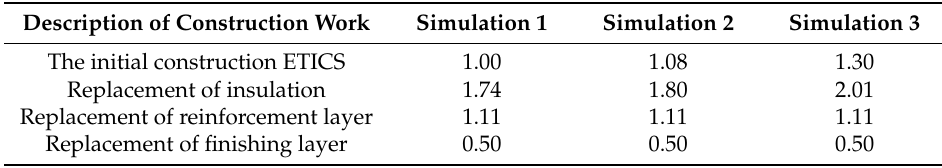
Table 2. The comparative ratio of initial construction and repair